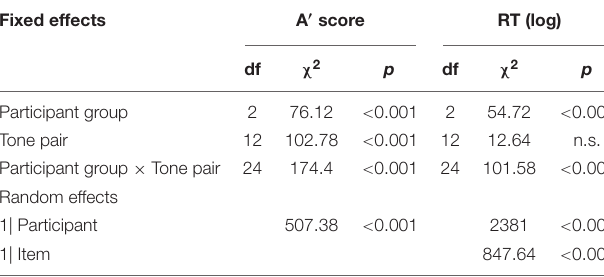
TABLE 3 | Summary of mixed effects models for A (cid:48) score and